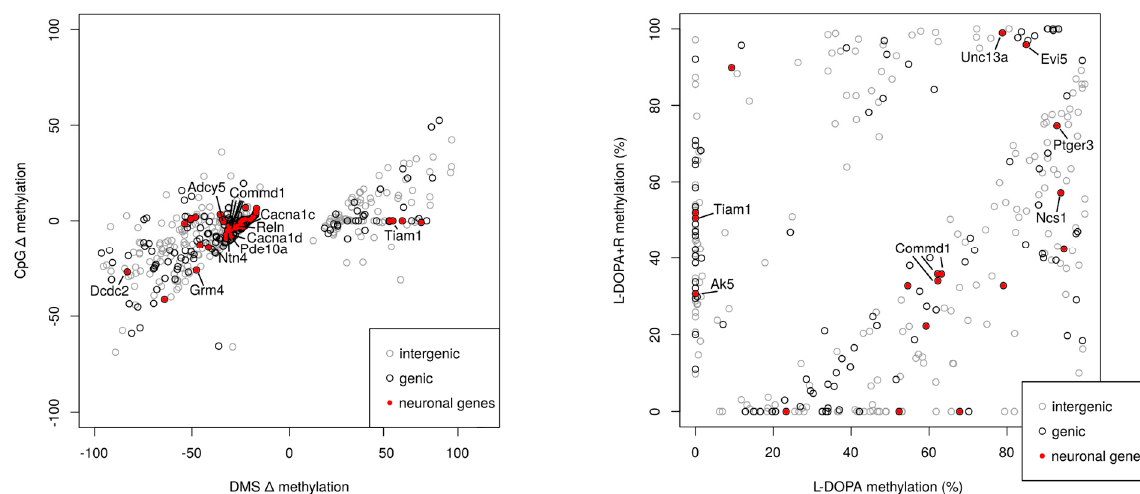
Figure 4. Comparison of DMS from L-DOPA vs. UNT and L-DOPA + R vs. UNT. ( A ) Difference of the number of DMS/bin of 1 Mb between L-DOPA + R vs. UNT and L-DOPA vs. UNT comparisons. Each dot corresponds to one bin. Black and grey colors alternate throughout the different chromosomes, numbered on the left side of the panel. ( B – D ) Methylation of selected genomic regions from bins indicated by red dots on panel ( A ) ( B : Chr1: 5S rRNA, C : Chr11: Pigx , and D : Chr14: Commd1 genes) ( E ) Plot of methylation changes are shown for DMS from either L-DOPA + R vs. UNT or L-DOPA vs. UNT comparisons. Only DMS from CpGs analyzed in both comparisons are shown if the methylation difference between L-DOPA and L-DOPA + R samples is at least 20%. Red dots indicate DMS of genes with relevance to LID. Grey circles indicate intergenic DMS. ( F ) DMS of L-DOPA vs. L-DOPA + R comparison. DMS of genes with relevance are indicated in